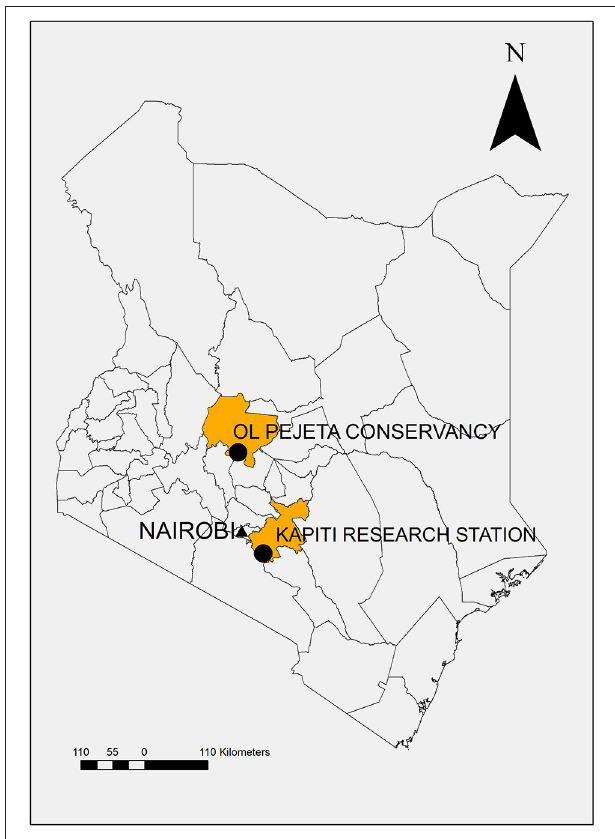
FIGURE 1 | Map of Kenya demonstrating study location, Ol Pejeta Conservancy, Laikipia County, and source of study animals, Kapiti Research Station, Machakos